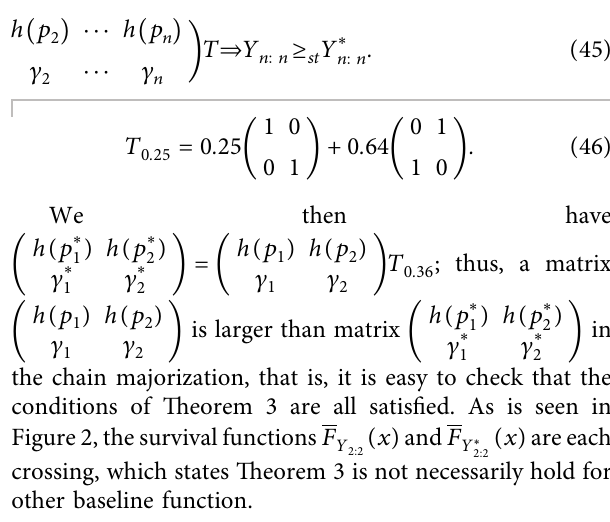
( x ) and F ( x ) are each Y ∗ 2 : 2 2 : 2